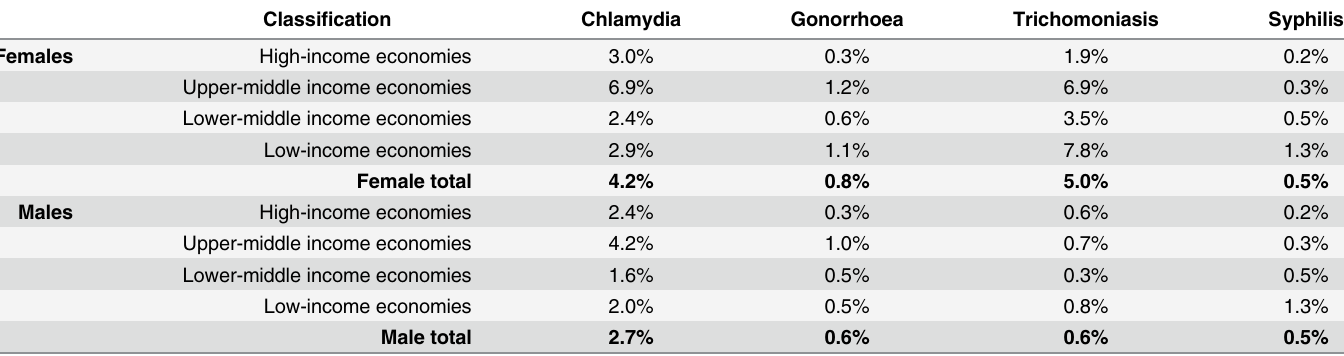
Table 5. Prevalence by infection and World Bank classification. Note: Estimates by World Bank classification are not identical to those by geographic region as three countries are not classified by World Bank and were therefore excluded: Cook Islands, Niue, and Nauru. Classi fi